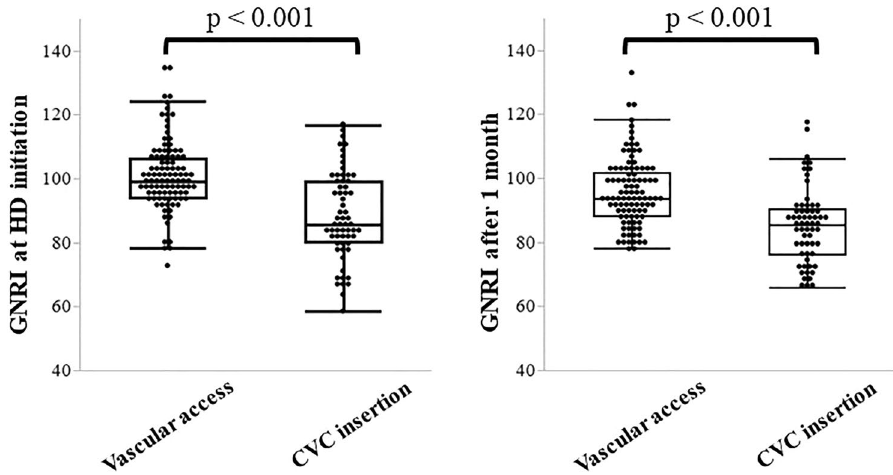
Figure 3. The transition of GNRI between HD initiation and 1 month after initiation. At the time of initiation, the GNRI score was significantly lower in the CVC group compared to that in the vascular access group. Similarly, at 1 month after initiation, the low value of GNRI persisted in the CVC insertion group. CVC, central venous catheter; GNRI, geriatric nutritional risk index; HD,